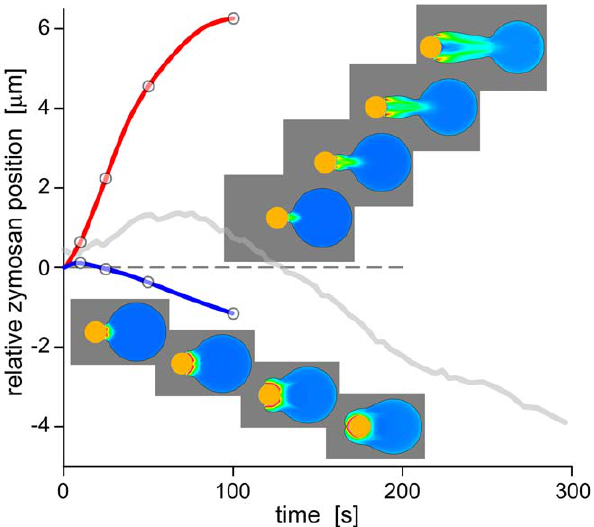
Figure 3. Elimination of potential mechanisms of zymosan phagocytosis due to mismatch between the predictions of the respective computer simulations and experimental results. The noisy, light-gray curve is a ‘‘benchmark’’ positional trace of a zymosan particle as typically measured in single-cell experiments. Trajectories of unsuccessful simulations are shown in blue (original Fc c model without attractive force) and red (after adding a full-strength protrusive force at the cell-target contact region). Included are snapshots of unsatisfactory simulations corresponding to the time points marked by circles.